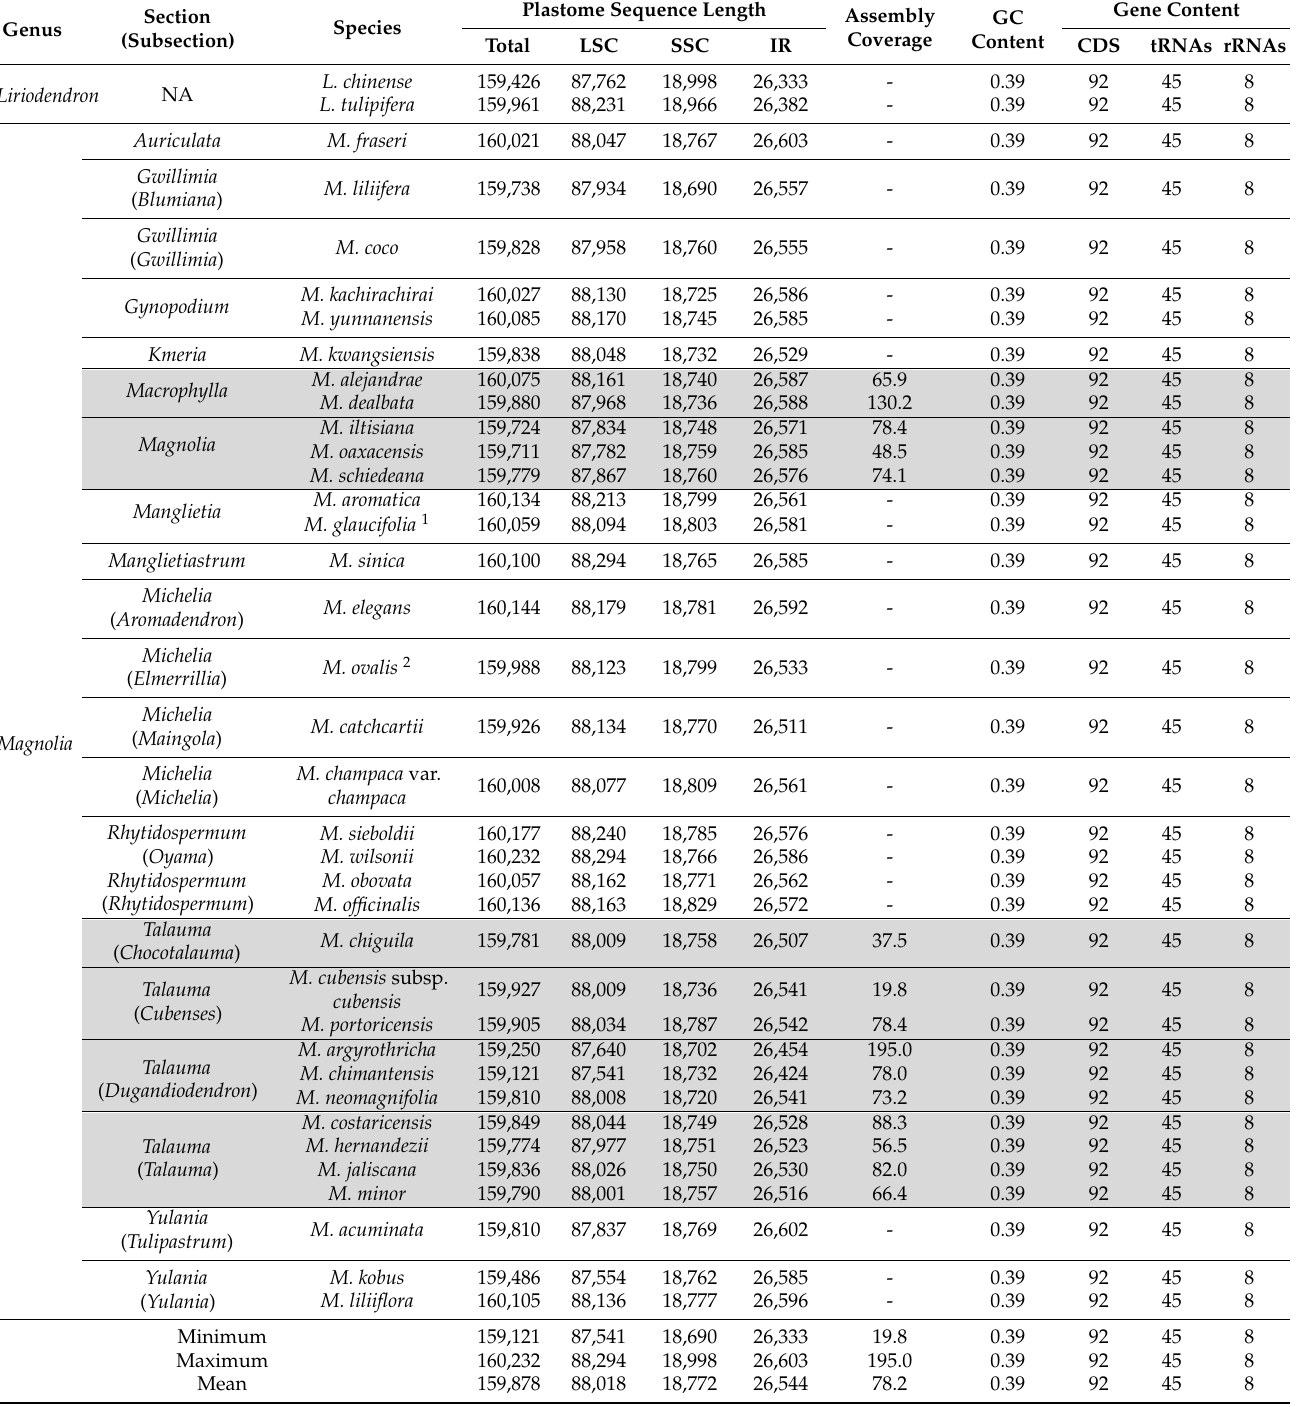
Table 1. Plastome sequence length, assembly coverage, GC content, and gene content of the 37 Magnoliaceae plastomes included in the analyses; newly assembled plastomes are highlighted in gray. The classification is according to [51,60]. NA = Not applicable, LSC = large single copy region, SSC = small single copy region, IR = inverted repeat region, CDS = coding DNA sequence, tRNA = transfer RNA, rRNA = ribosomal RNA. 1 : Synonym of Magnolia conifera var. chingii , treated as M. glaucifolia in [43]. 2 : Synonym of M. vrieseana , treated as M. ovalis in